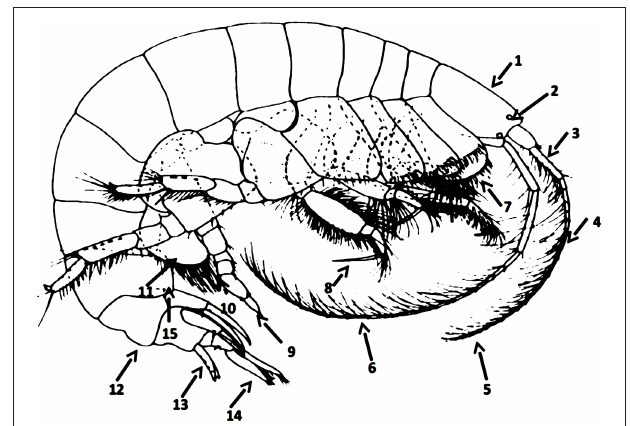
FIGURE 1 | Main morphological characters used in the female Ampelisca key. 1. Head shape. 2. Corneal lenses. 3. Length of the peduncle of the first pairs of antennae. 4. Length of the first pairs of antennae vs. length of the peduncle of the second pairs of antennae. 5. Length of the first pair of antennae. 6. Length of the second pairs of antennae. 7. Shape of the coxal plates. 8. Length of the pereiopod 3–4 dactylus. 9. Shape and length of the pereiopod 7 dactylus. 10. Posterior lobe on merus. 11. Shape of the basal of the pereiopod 7 and presence/absence of spines. 12. Form of the carina of the urosome 1. 13. Form of the telson and absence of presence of dorsal spines and setae. 14. Length of the rami of the uropod 3. 15. Postero distal form of the